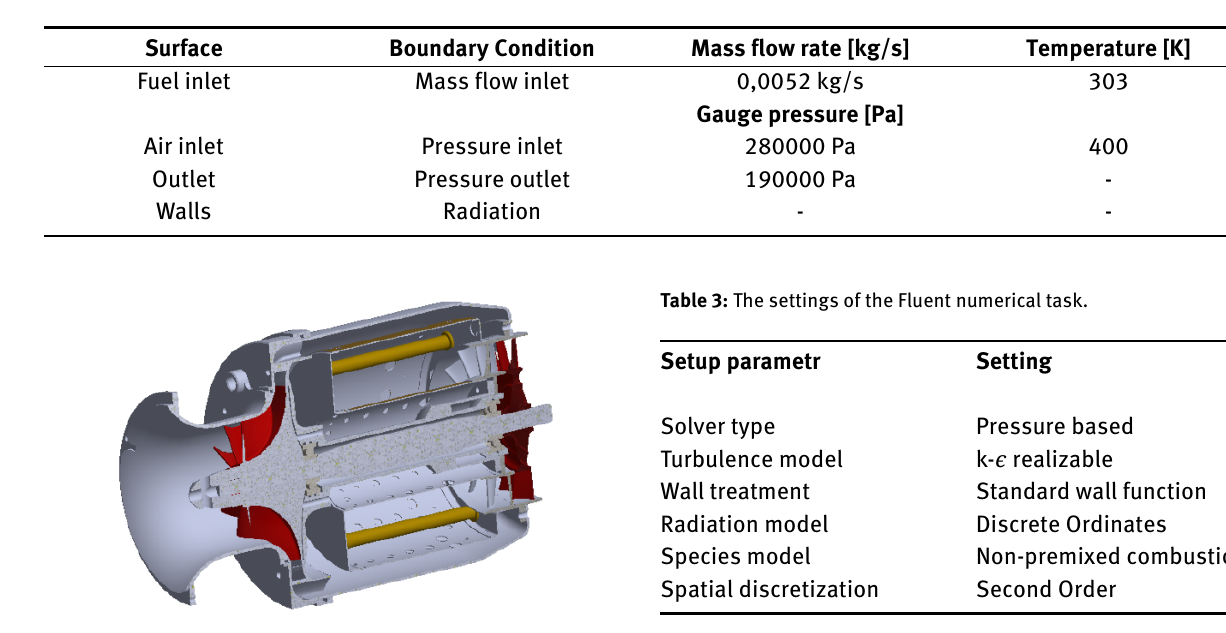
Figure 3: Geometry of the GTM-140.